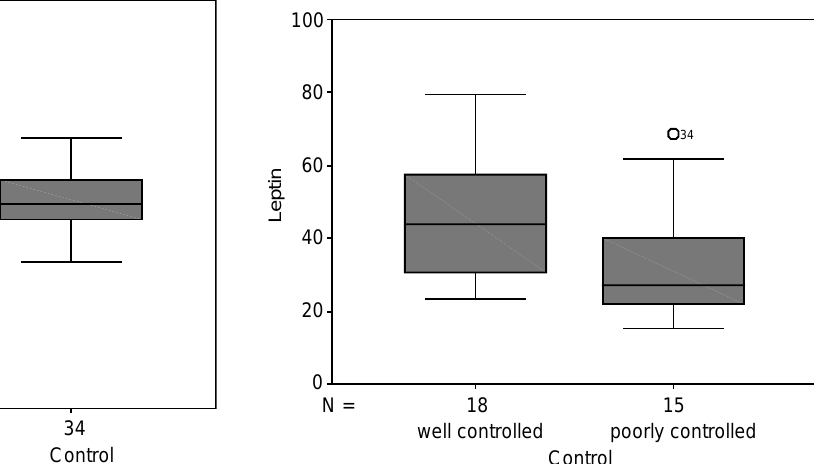
FIG. 1. Leptin levels in diabetes and control groups (p (cid:6) / 0.019).